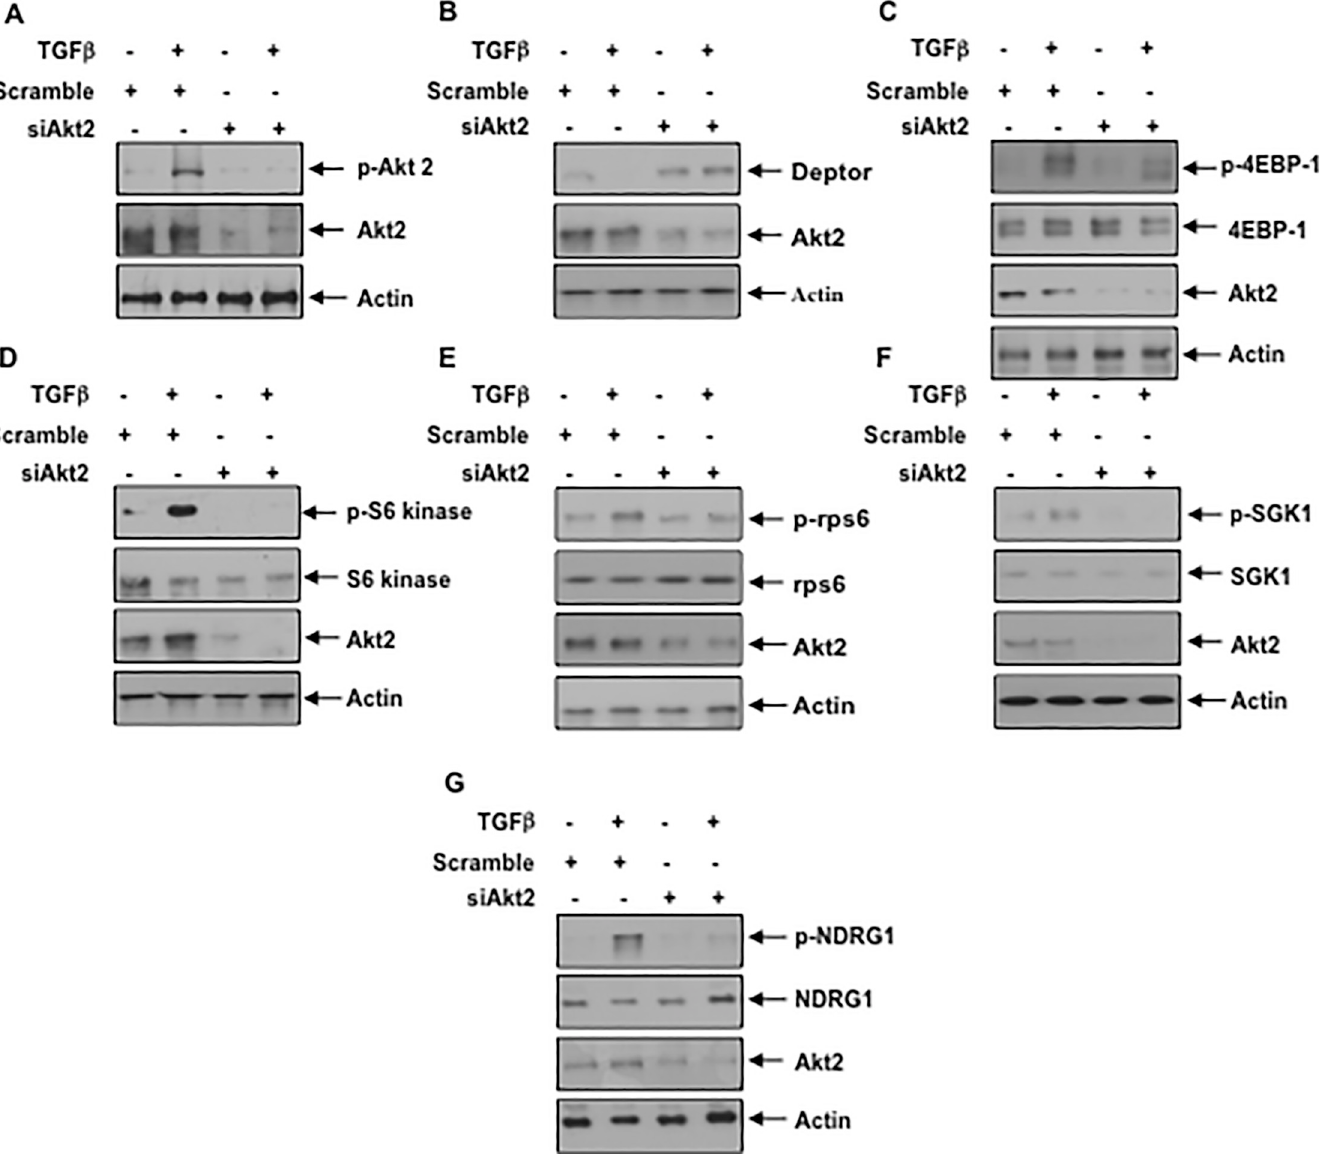
Fig 7. siRNA against Akt2 blocks TGF β induced suppression of deptor and activation of mTORC1 and mTORC2. (A–G) Podocytes were transfected with scramble RNA and siRNA against Akt2. The transfected cells were starved and treated with TGF β The cell lysates were immunoblotted with indicated antibodies. Representative of 4 independent experiments is shown. The quantification is shown in the S10